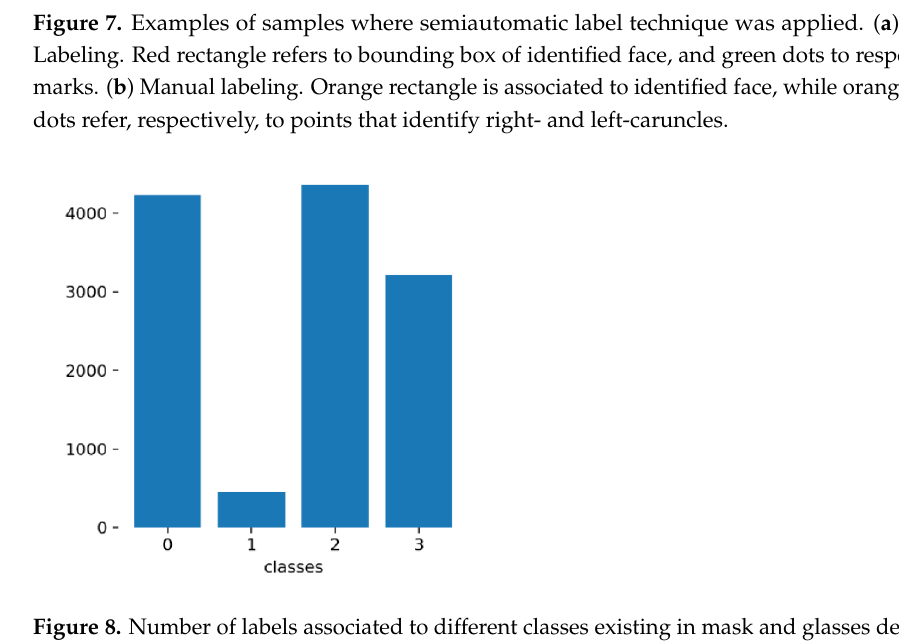
Figure 8. Number of labels associated to different classes existing in mask and glasses detection task. Different classes can be consulted in Table